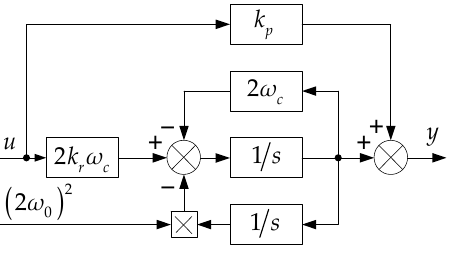
Figure 12. Improved adaptive PR controller.